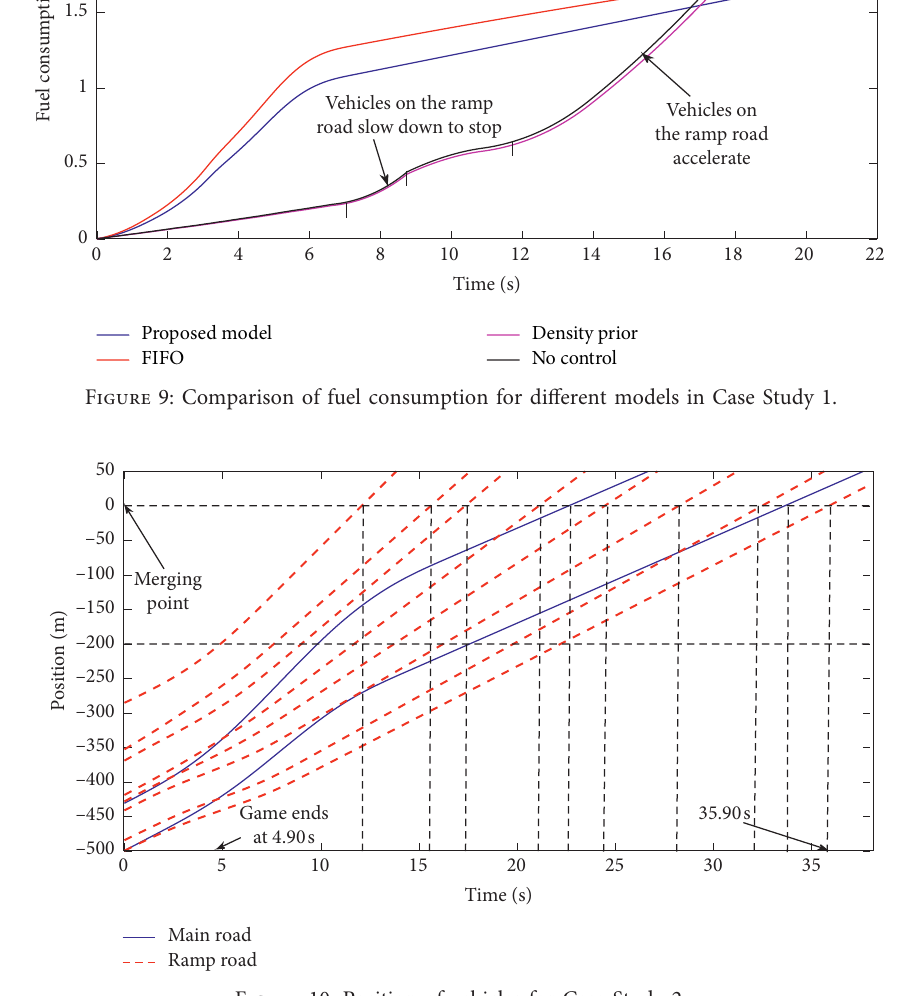
Figure 10: Position of vehicles for Case Study 2.